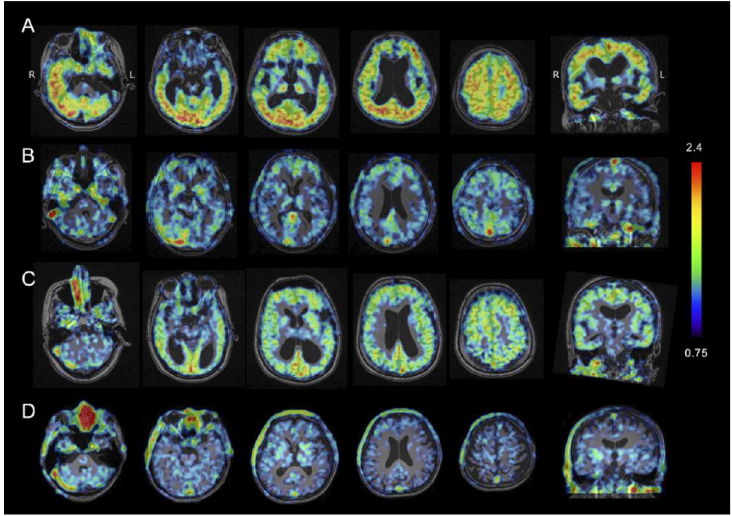
Figure 2. Tau PET using PBB3 in a patient with familial Alzheimer’s disease with Osaka mutation (FAD (Osaka)) ( A ); a patient of early stage of sporadic Alzheimer’s disease (early SAD) ( B ); a patient with advanced stage of SAD ( C ); and a healthy control (HC) ( D ). The heat map range (colored bar) of tau tracer uptake indicates standard uptake value ratio (SUVR) with reference to the midbrain. In the FAD (Osaka) patient, noticeable PBB3 accumulation was observed in the cerebral cortex and the cerebellar cortex, whereas the AD patient had much less tau accumulation that was more localized in the frontal, parietal, and lateral temporal cortices.